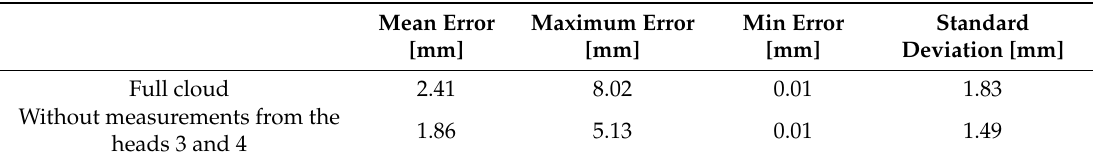
Table 4. The errors between measurements using the proposed scanner and the reference Metris MMCX80 laser scanner.